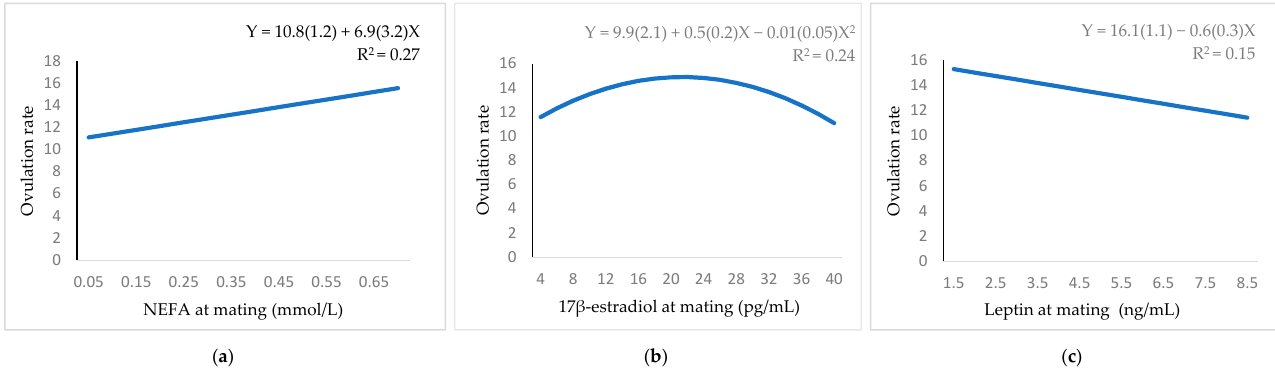
Figure 2. Regression equation (standard error between brackets) at mating for the relationship between ovulation rate: ( a ) NEFA; ( b ) 17 β -estradiol; ( c ) leptin.